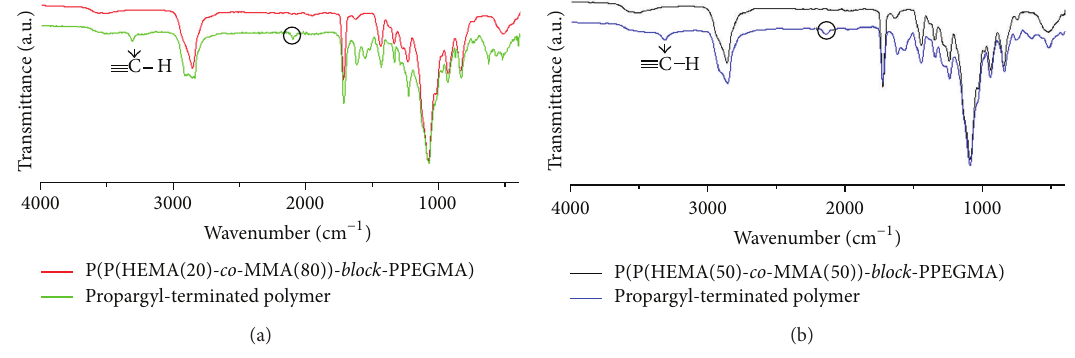
Figure 9: The FT-IR spectra of P(HEMA- co -MMA)- block -PPEGMA ( 2b, 2d ) and alkyne-P(HEMA- co -MMA)- block -PPEGMA ( 3b, 3d ).